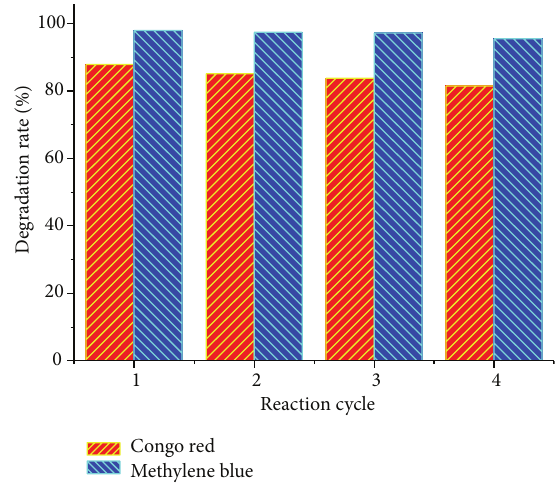
Figure 9: The recycle use of HPW@yeast in decoloring of MB and Cong